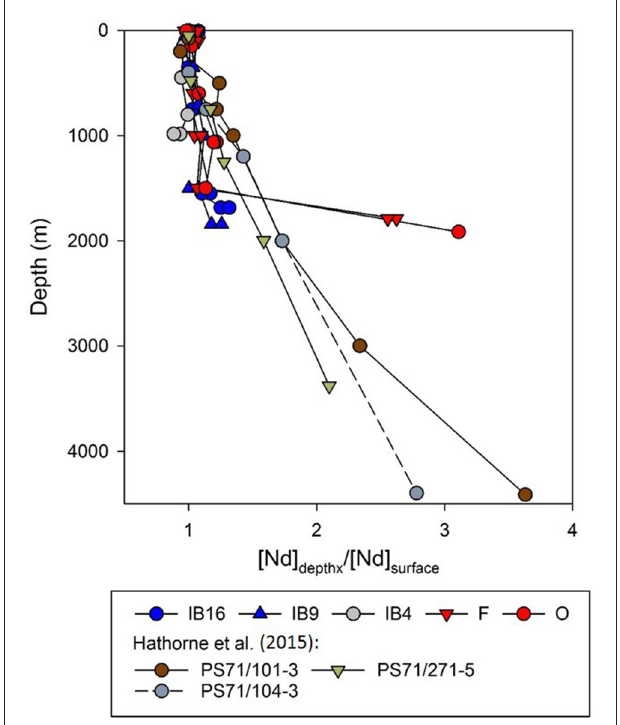
FIGURE 7 | The water column increase of Nd concentrations at depth relative to the surface ocean ([Nd] depthx /[Nd] surface ) for the 5 open ocean stations, with comparison to selected stations in the Southern Ocean in Hathorne et al.